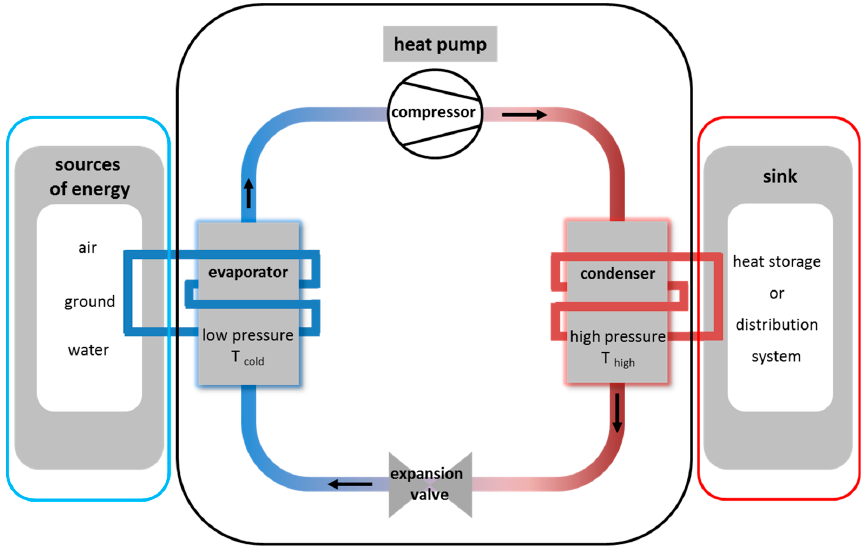
Figure 1. Principle and functional elements of a heat pump.